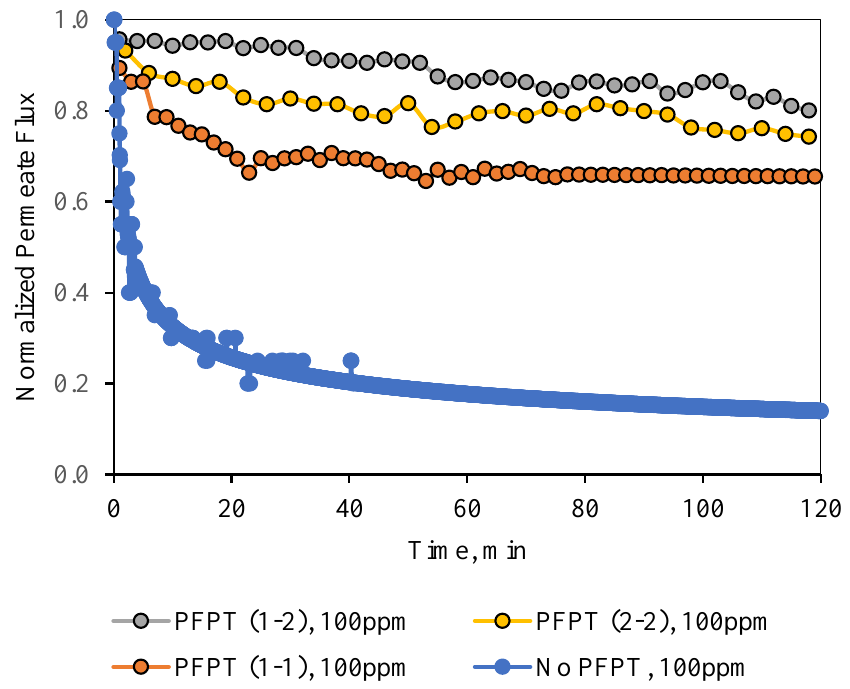
Figure 12. Normalized permeate flux decline for normal filtration and the 1-1, 1-2, and 2-2 PFPT as a function of time for a feed of 100 ppm.